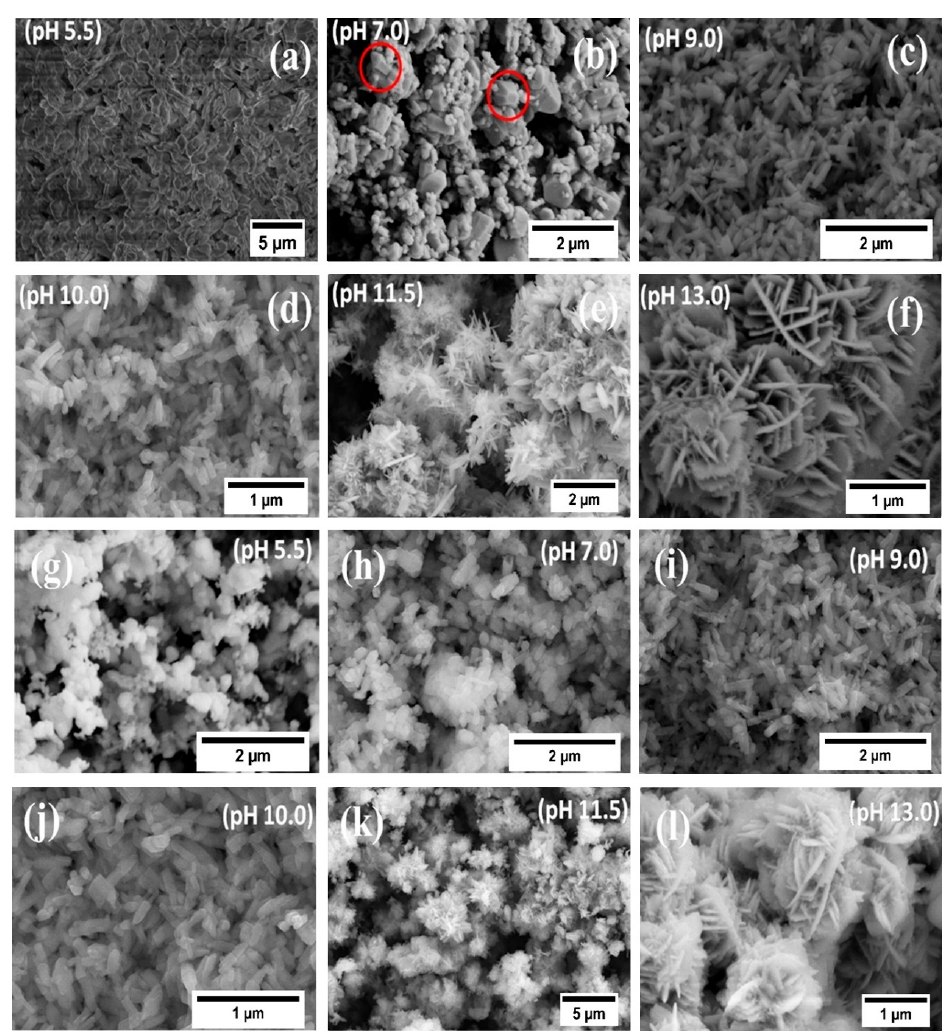
Figure 2. The scanning electron microscopy (SEM) image of synthesized ZnO powder: ( a )–( f ) for pH 5.5, 7, 9, 10, 11.5, and 13.0, respectively dried at 80 °C for 24 h; ( g )–( l ) for pH 5.5, 7, 9, 10, 11.5, and 13.0, respectively dried at 250 °C for 5 h.